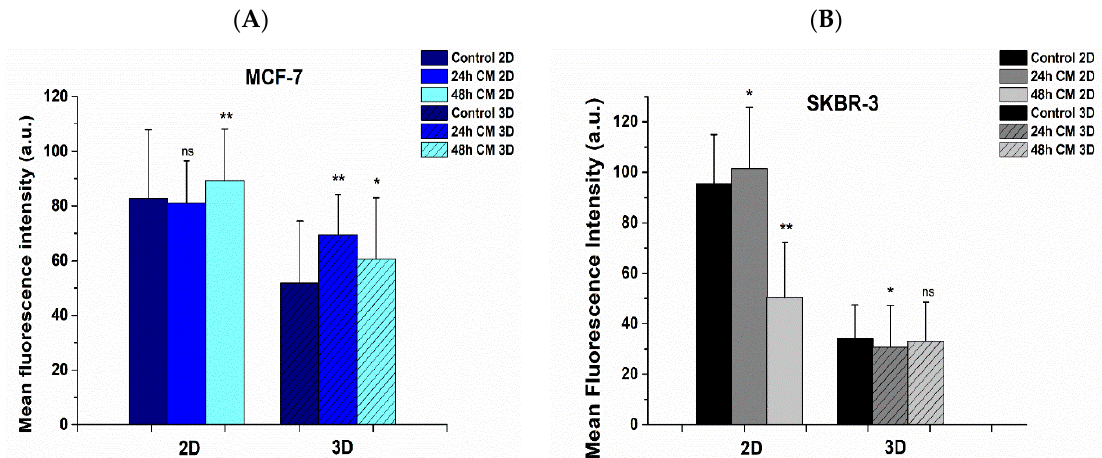
Figure 9. Quantitative confocal microscopy analysis via ImageJ displaying mean fluorescence intensity. MCF-7 ( A ) and SKBR-3 ( B ) cancer cells were incubated with hUMSCs-CM at 24 h and 48 h, respectively. F-actin was stained with conjugated phalloidin and nucleus with Hoechst. Quantification of F-actin mean intensity yielded differences in actin staining that were consistent with the trends observed in the cell stiffness measurements. Data represent mean values ± SD of mean immunofluorescence intensity of more than three independent experiments are represented, ns p > 0.05, * p < 0.05. ** p < 0.01.